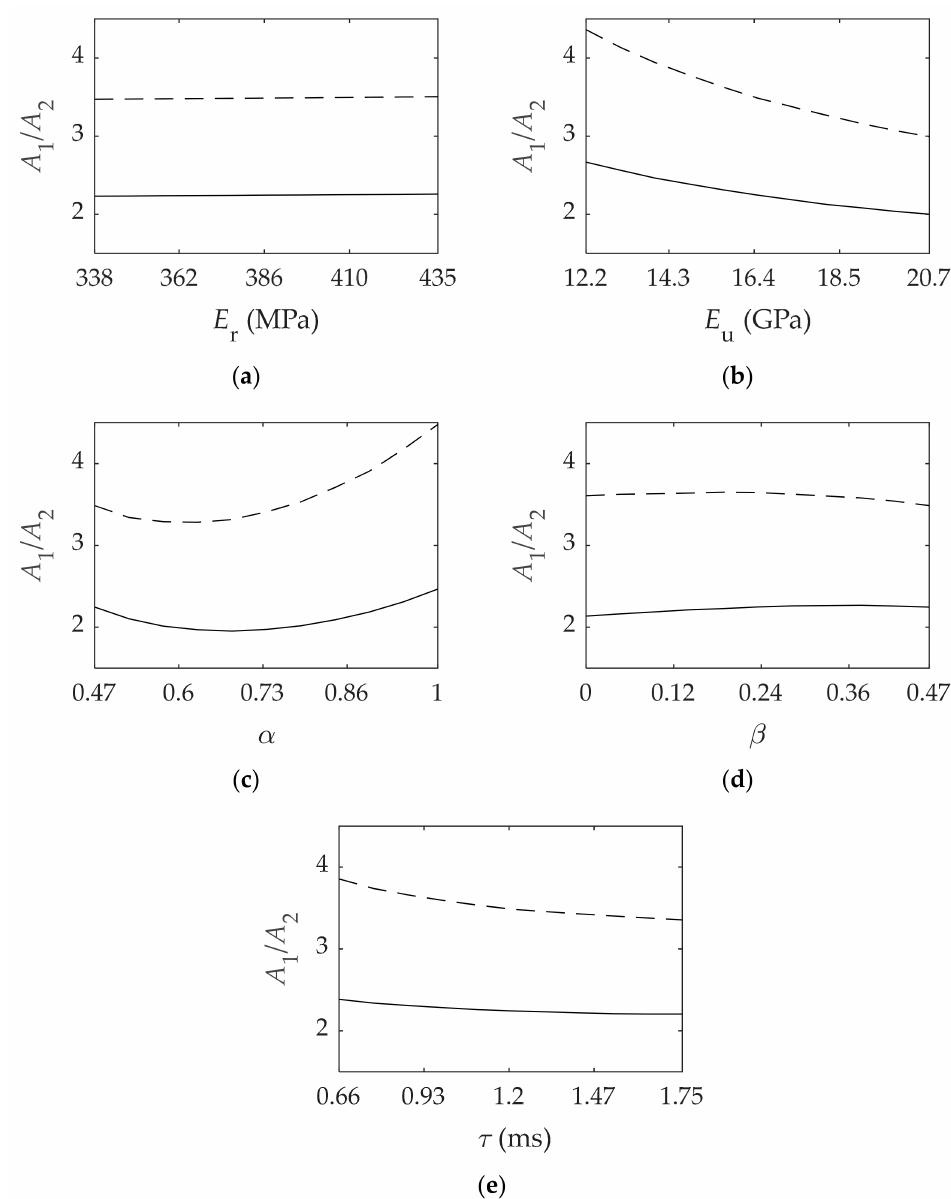
Figure 3. Viscoelastic material parameters influence on the ratio between the first relative maximum and the first relative minimum A 1 / A 2 for the asymmetrical ( ) and symmetrical